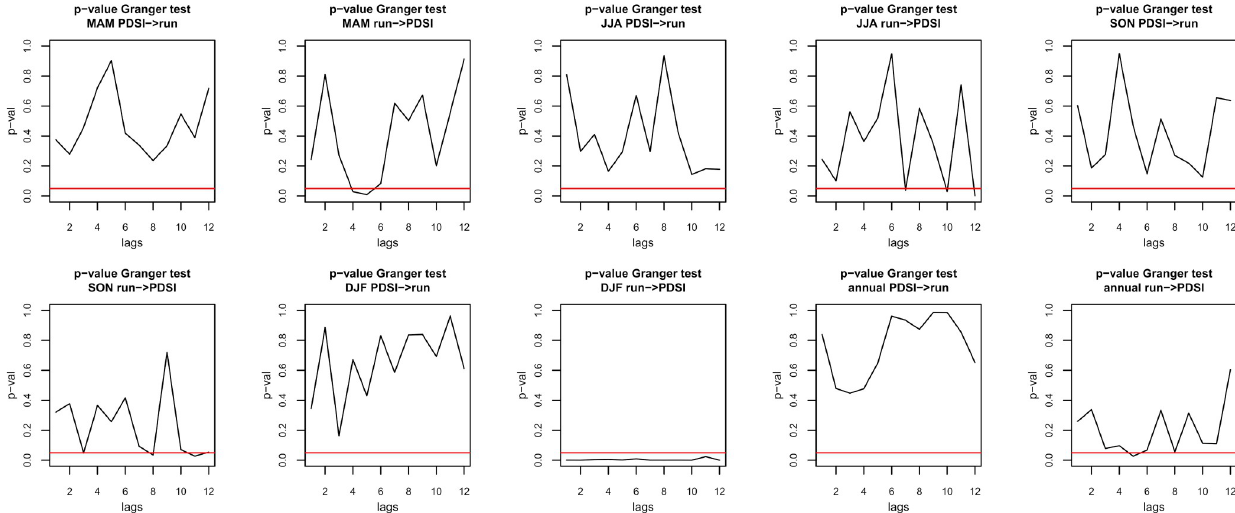
Fig 7. P-values of the Granger test for causality using lags between 0 and 11 years. PDSI cause run-off (PDSI- > run) and run-off cause PDSI (run- > PDSI). Significance level of 5% is marked with a horizontal red line (see Table 2).